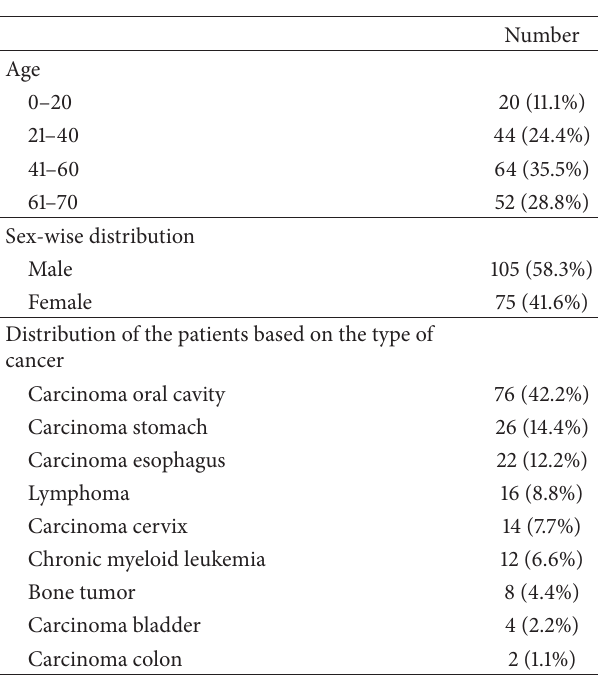
Table 1: Demographic data and the distribution of patients based on cancer type.